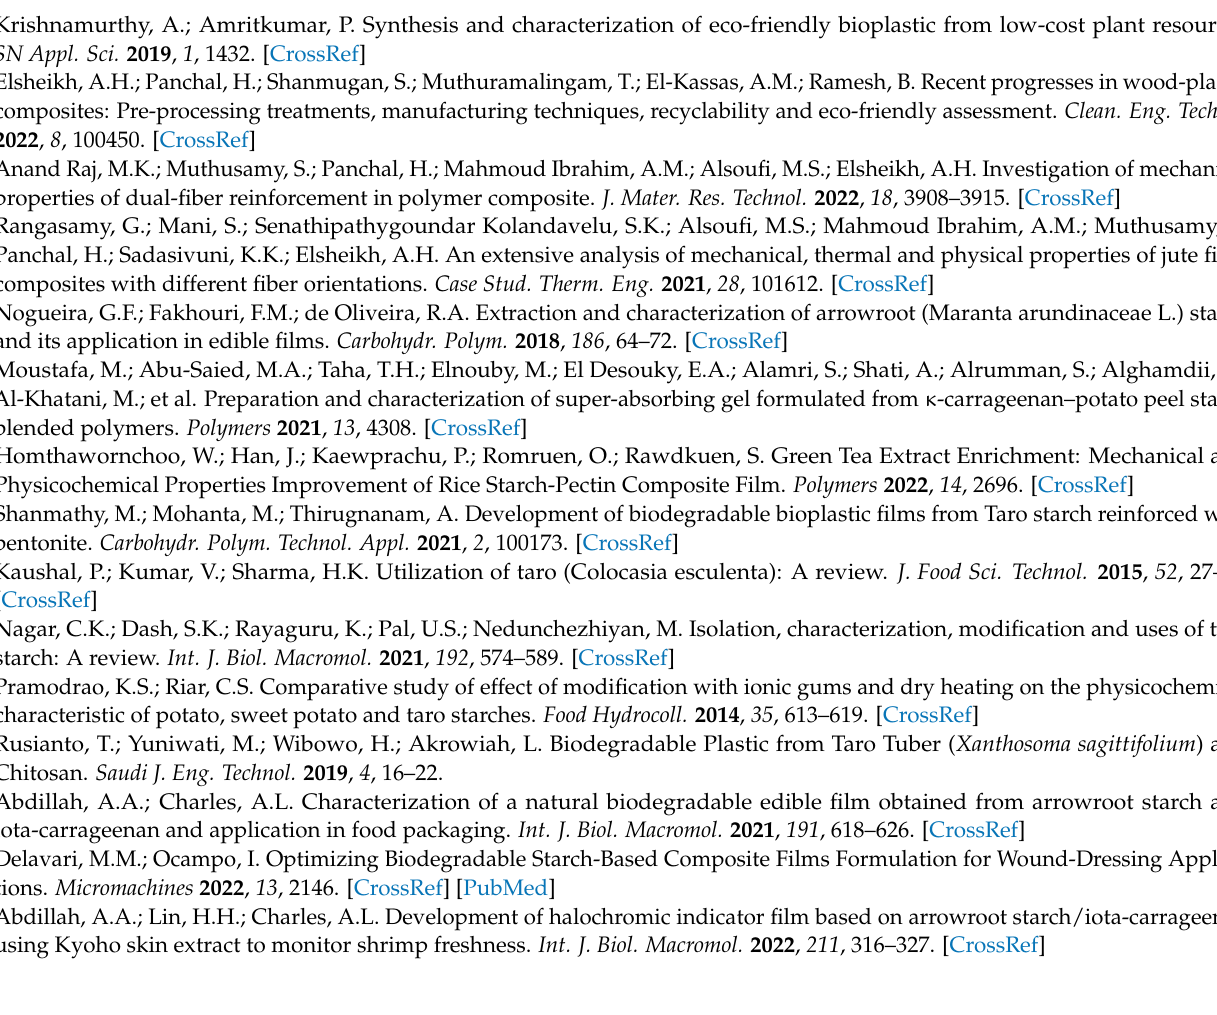
Figure S1: Water contact angle of taro peel starch